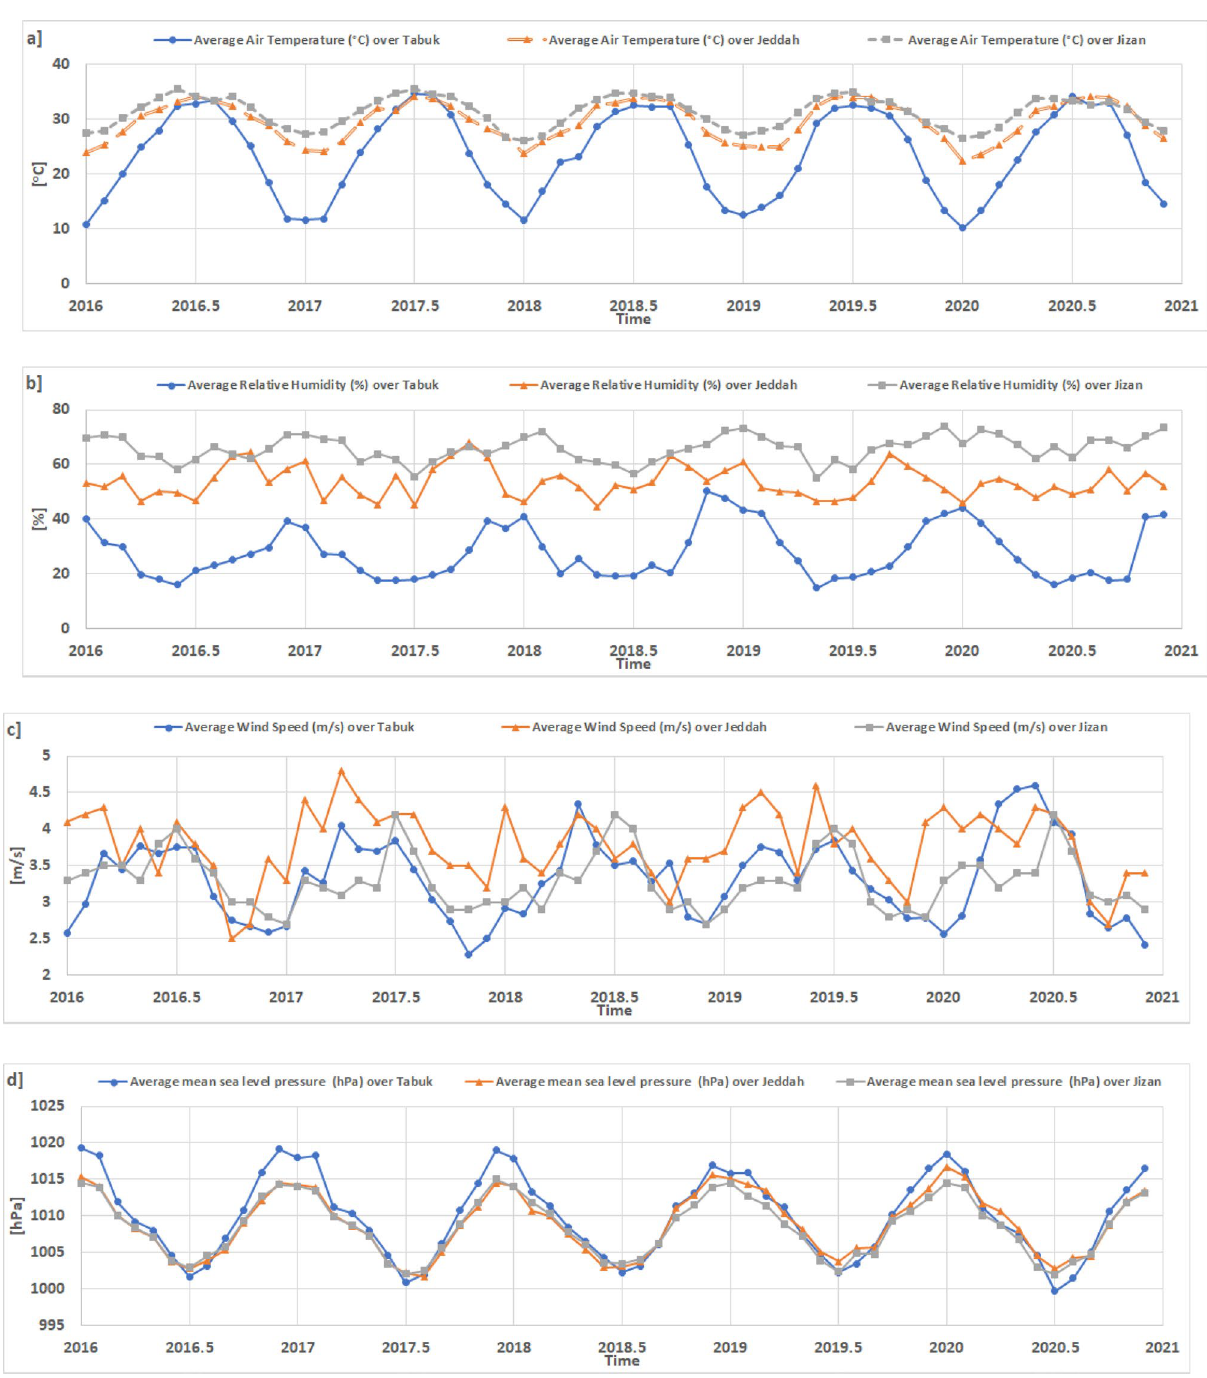
Figure 2. Monthly average time series for the parameters studied based on hourly observation data (2016– 2020) in Tabuk, Jeddah and Jizan. Microsoft Office (Excel). Version 365. https:// www. office.